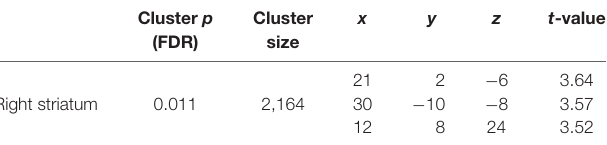
TABLE 3 | Significant difference in gray matter volume (GMV) between the groups (Control >